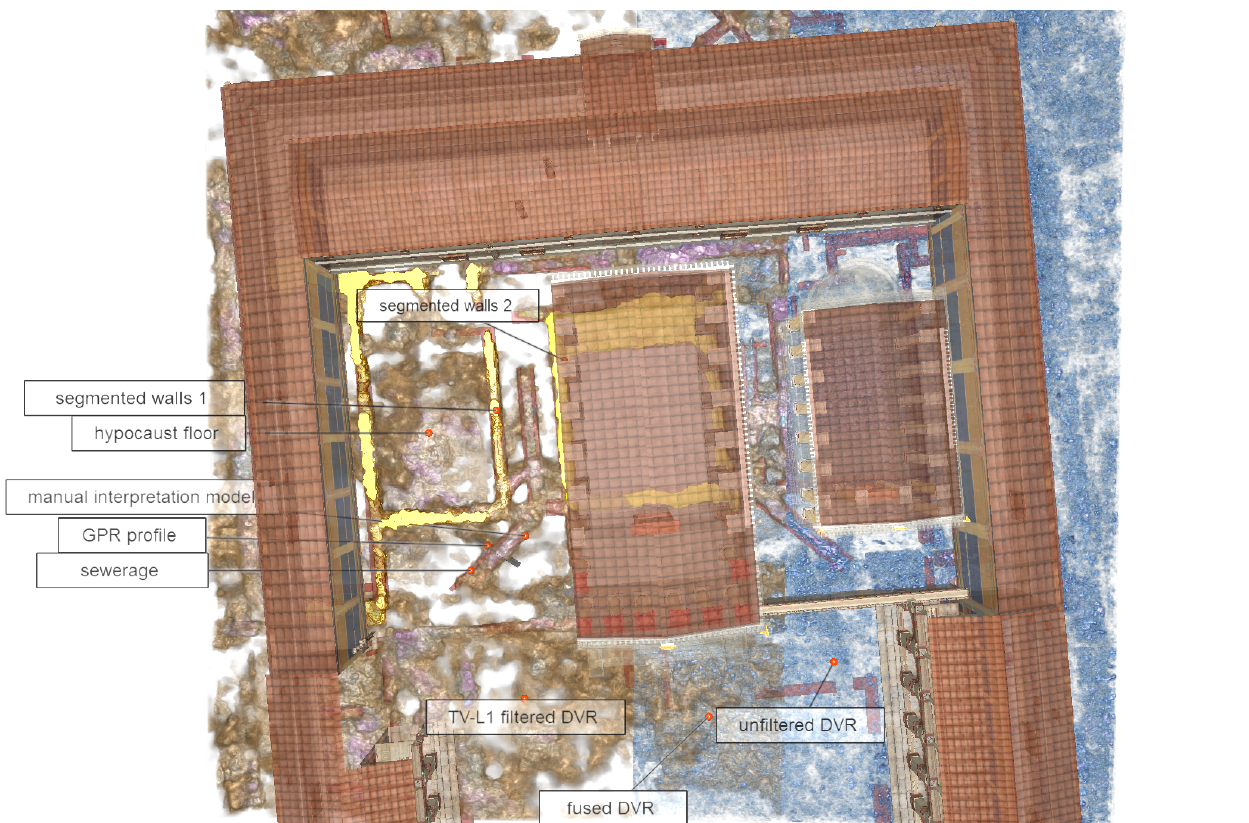
Figure 16. Top view of the scene from Figure 15 without terrain and parts of the 3D model cut out (Section 2.6) for better visibility of the prospection datasets, interpretation model, and the segmented walls (Section